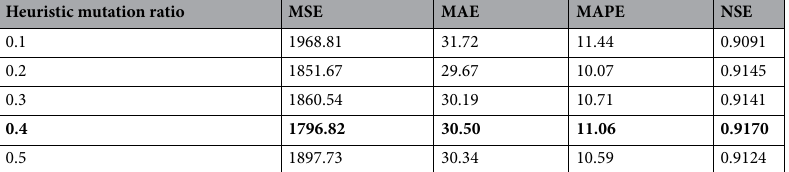
Table 5. Impact of heuristic mutation probability. Best results are highlighted in bold text. Using the heuristic mutation probability of 0.4 yields the best performance concerning all metrics.